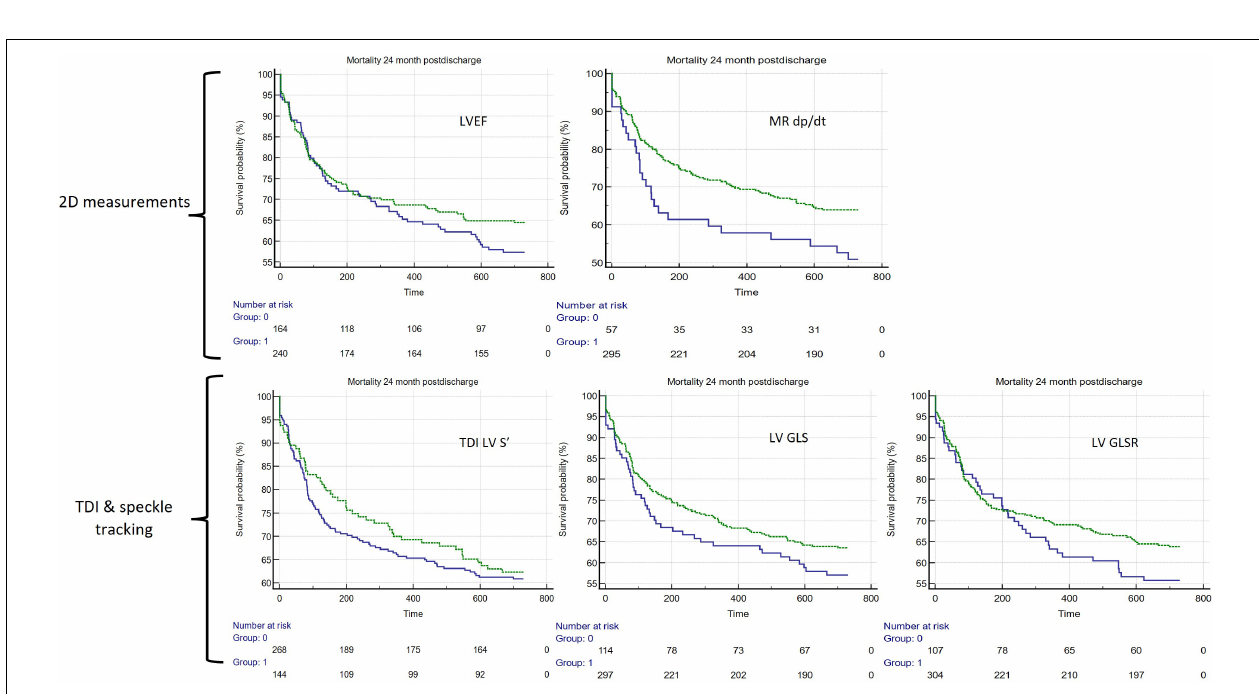
FIGURE 3 | Unadjusted Kaplan–Meier curves comparing 5 different assessments of LV systolic function. In all panels, green lines represent preserved systolic function and blue lines represent impaired function (clockwise from top-left): LVEF > 48%, LV MR dp/dt < 570 mmHg/s, LV TDI S’ ≤ 0.06 m/s, LV GLS > − 6.32%, LV GLSR > − 0.86 s − 1 . LVEF, LV ejection fraction; LV MR dp/dt, LV mitral regurgitation (cid:49) p/ (cid:49) t; LV S’, LV Tissue Doppler Imaging (TDI) lateral mitral annular peak systolic velocity; LV GLS, LV Global Longitudinal Strain; LV GLSR, LV global longitudinal strain rate.